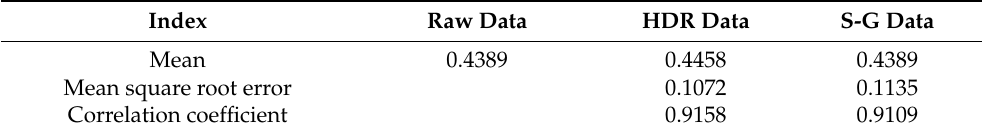
Figure 4. NDVI timing reconstruction and crops weather characteristic extraction. ( a ) NDVI timing refactoring, different filtering methods are used to smooth the original NDVI time series curve; ( b ) Crops weather characteristic extraction. Curvature maximum means the location with the fastest NDVI improvement, and curvature minimum means the location where NDVI decreases the fastest. Table 2. NDVI timing refactoring parameter